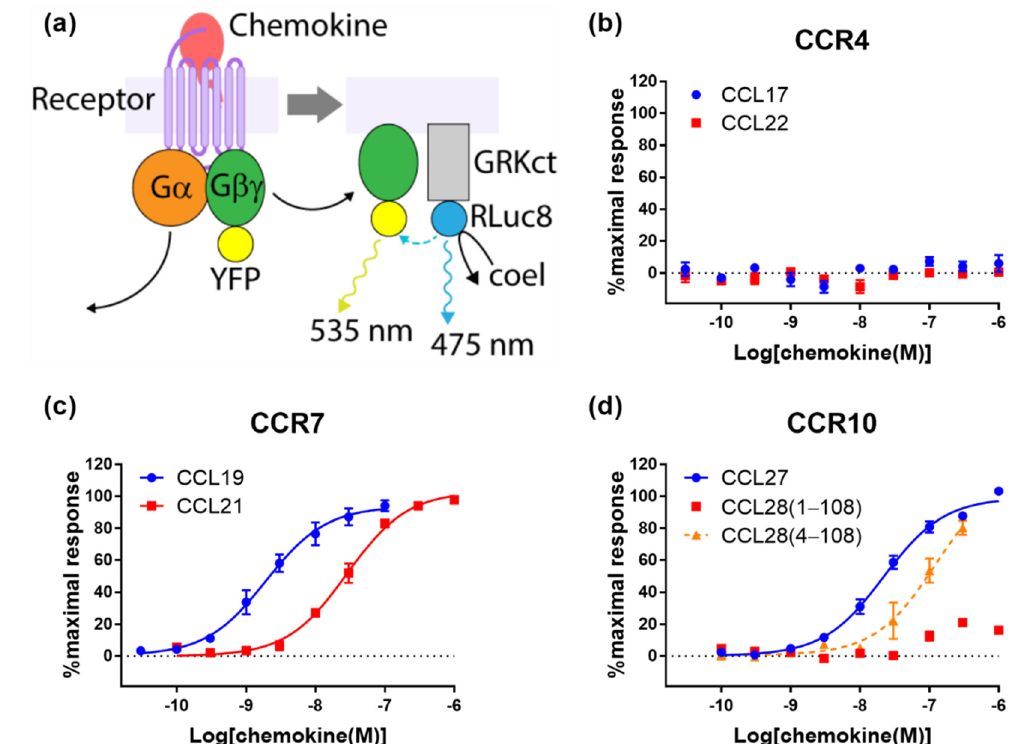
Figure 2. Chemokine ligands differentially stimulate G protein activation via CCR4, CCR7 and CCR10. ( a ) The principle of the BRET-based G-protein recruitment assay. RLuc8 is fused at the C-terminus tail of GRK3 (GRKct), which is localized to the plasma membrane, and the YFP variant Venus is tagged at the G β 1 γ 2 dimer. Upon activation of a chemokine receptor, the activity of the trimeric G protein complex (G α i2 was overexpressed in this assay) can be detected as the dissociation of G α i and G βγ ; the latter binds to the GRK3 C-terminal tail, bringing the YFP and RLuc8 into close proximity and enabling resonance energy transfer after addition of coelenterazine h (coel). ( b – d ) Chemokine-induced G-protein activation at ( b ) CCR4 ( c ) CCR7, and ( d ) CCR10. A dashed line of best fit is shown in the case that the signal does not reach saturation. The presented data are mean ± SEM of at least three independent experiments, each performed in triplicate.